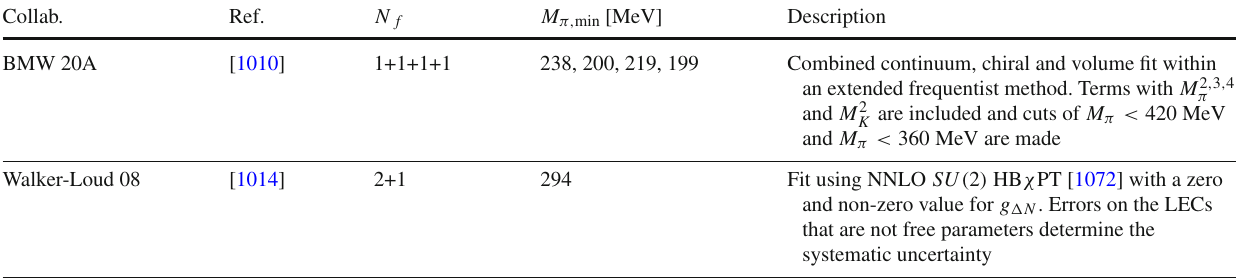
Table 195 Chiral extrapolation/minimum pion mass in determinations of σ π N and σ s from the Feynman–Hellmann method Collab.